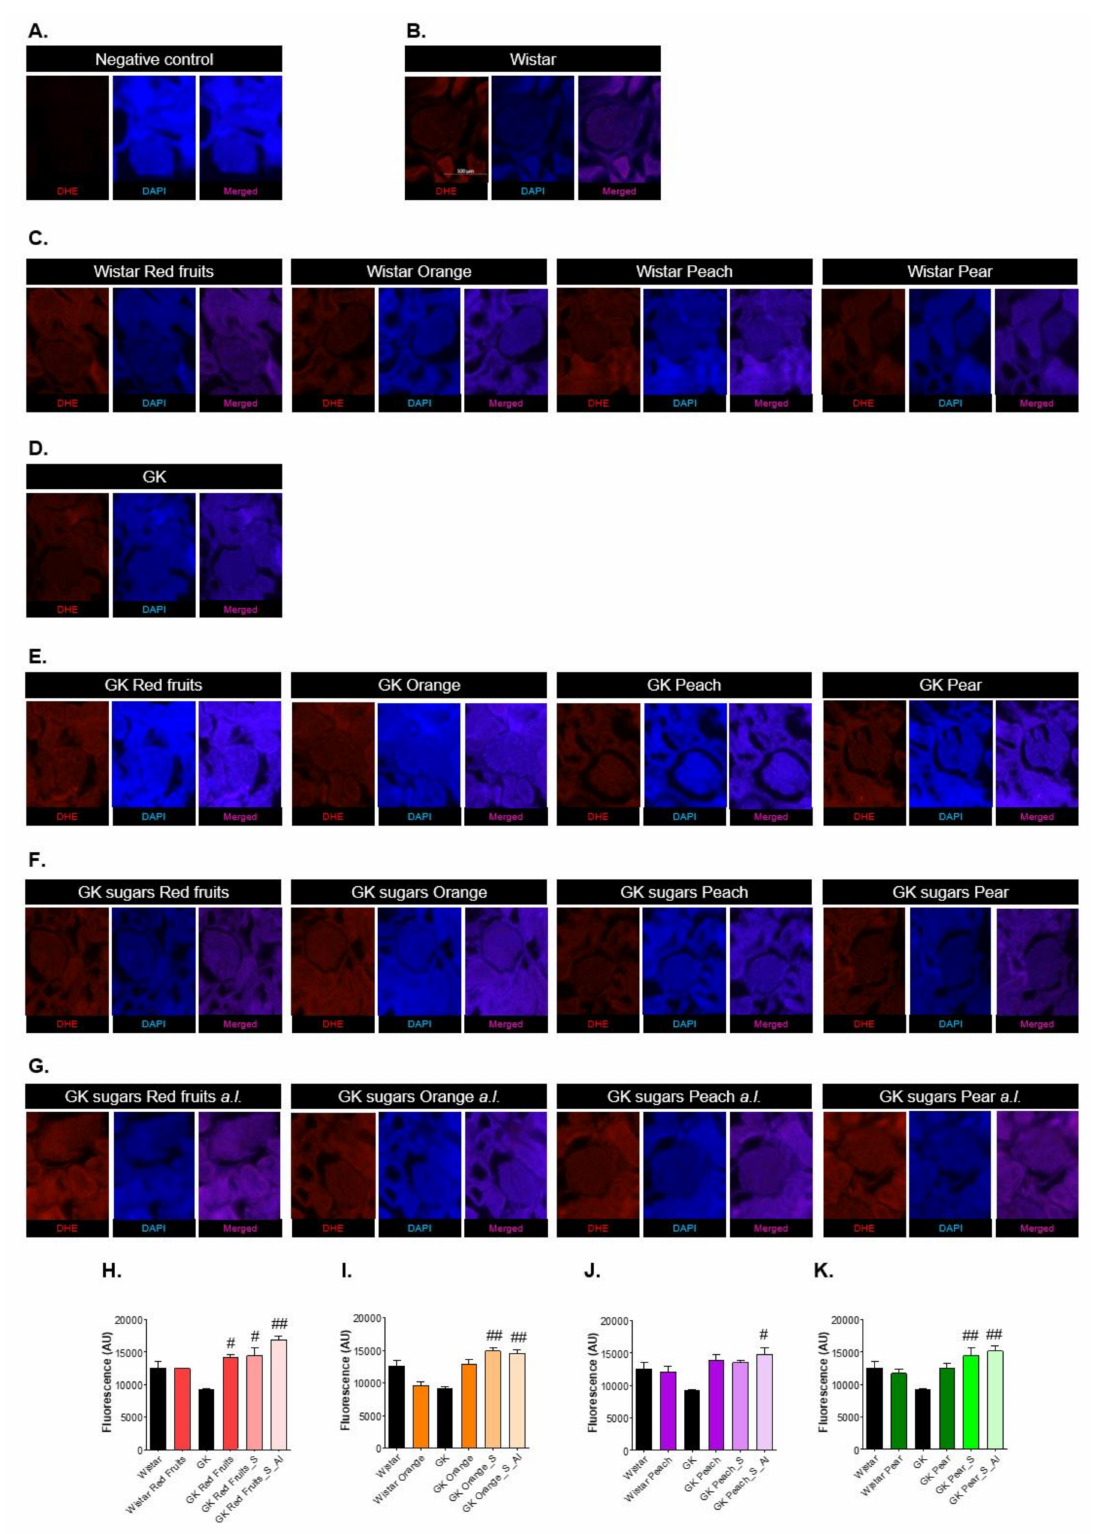
Figure 9. Detection of the dihydroethidium (DHE) probe for superoxide anion determination. ( A ) shows the negative control (no probe). Representative images of the glomeruli are shown for control Wistar rats ( B ), Wistar rats maintained with ad libitum access to fruit juices ( C ), control GK rats ( D ), GK rats maintained with ad libitum access to fruit juices ( E ), GK rats treated with respective sugary solutions matched in sugar profile, concentration and quantity ( F ), and GK rats maintained with ad libitum access to the same sugary solutions ( G ). ( H – K ) show the quantification of glomerular DHE staining for the different experimental conditions of each sample tested. # different from GK. 1 symbol, p < 0.05; 2 symbols, p <